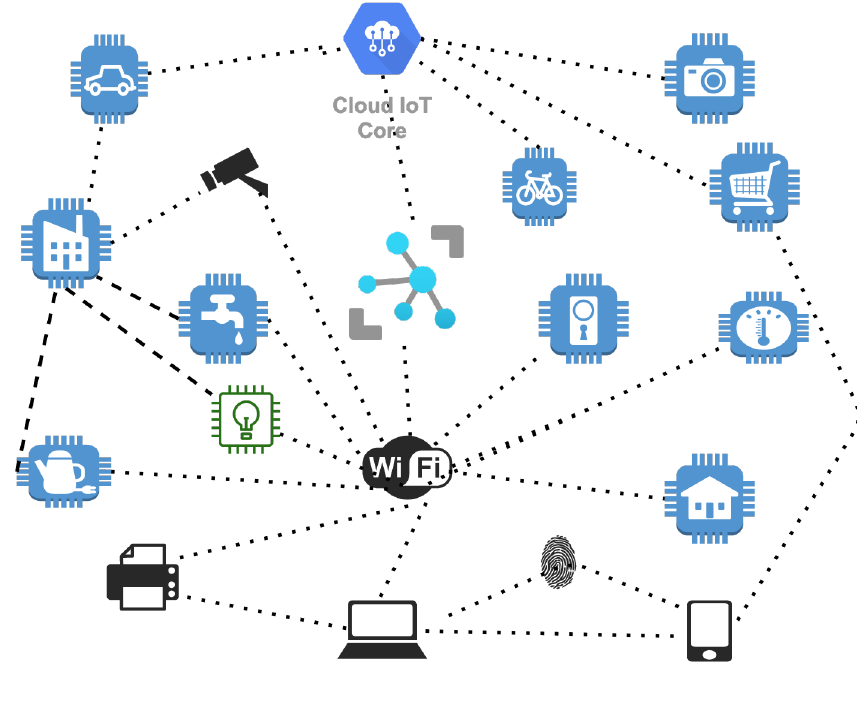
Figure 1. Intelligent internet